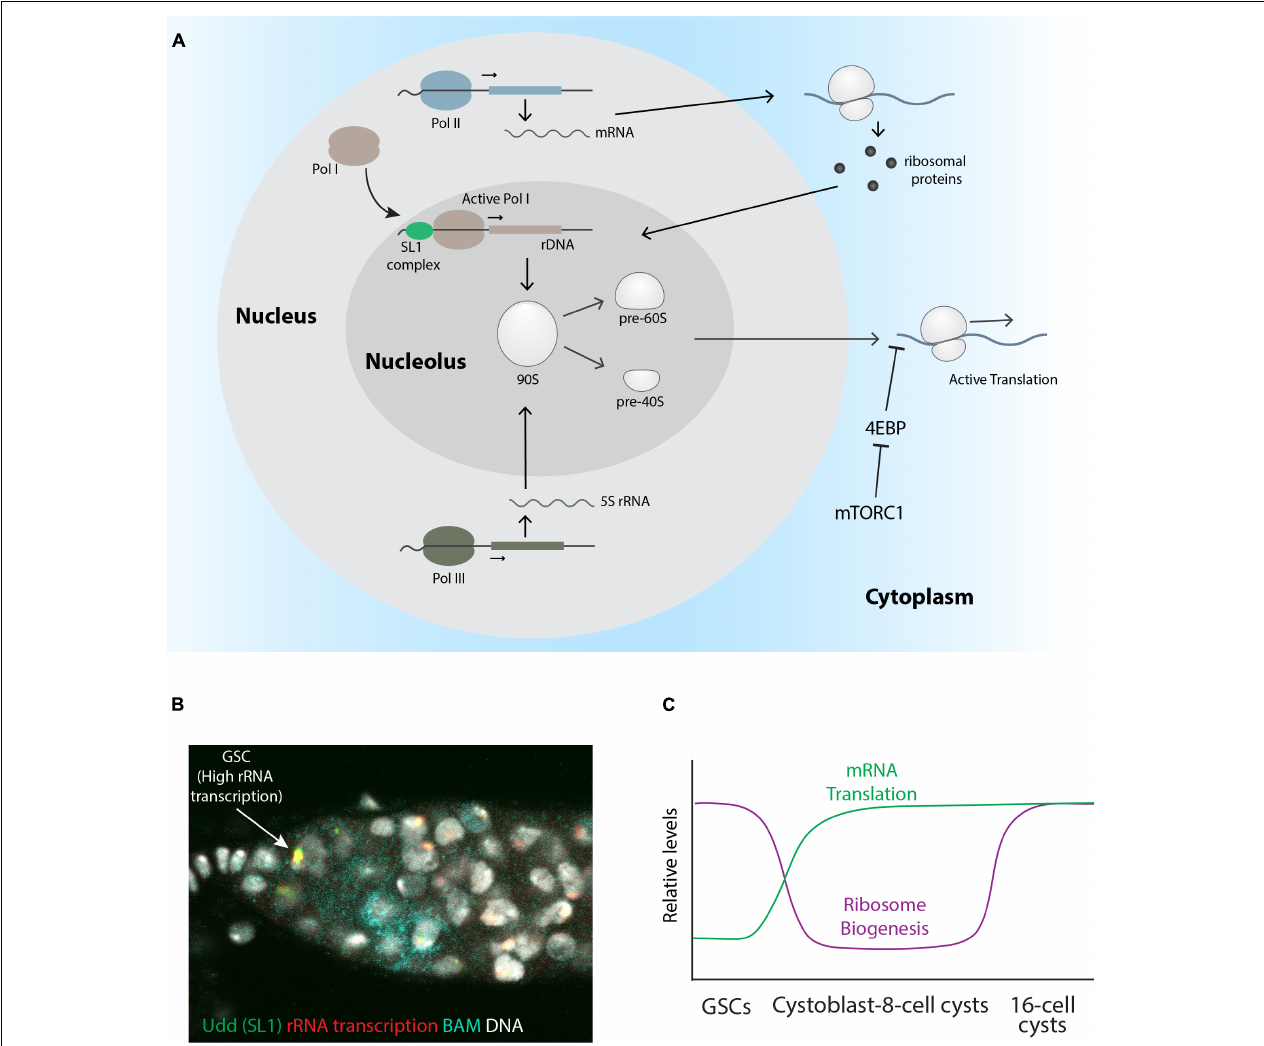
FIGURE 6 | Stage specific regulation of rRNA transcription, ribosome biogenesis, and global protein translation. (A) Schematic describing the process of ribosome biogenesis. (B) A wildtype Drosophila germarium pulse-labeled with Br-UTP to mark nascent rRNA (red) and stained for Udd (green), Bam (cyan), and DNA (gray). The arrow points to a GSC with relatively high rRNA transcription and Udd levels. (C) A graph showing the relative levels of ribosome biogenesis and mRNA translation based on published